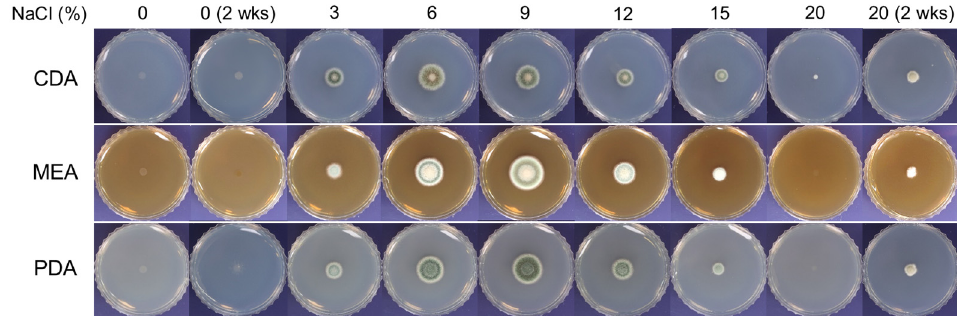
Figure 1. Halophilic growth of SK1-1. Conidia of SK1-1 (10 5 conidia in sterile water) were inoculated on Czapek Dox agar (CDA), malt extract agar (MEA), and potato dextrose agar (PDA) containing 0%, 3%, 6%, 9%, 12%, 15%, and 20% ( w/v ) NaCl. Following incubation at 28 °C for 5 days or 2 weeks (2 wks), colony growth and diameter were compared to optimize the NaCl concentration for maximum radial growth of SK1-1.